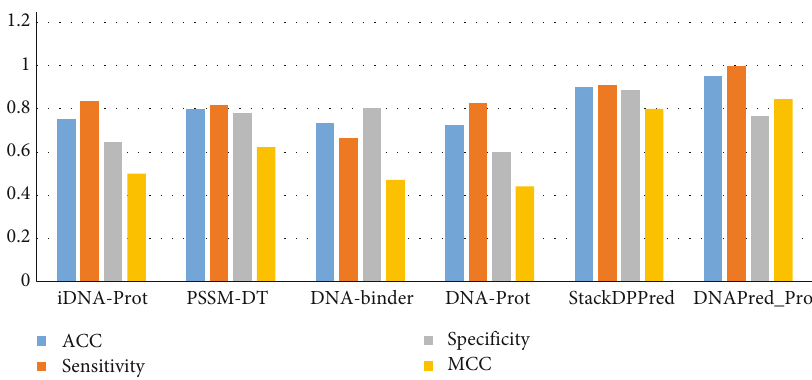
Figure 14: Jackknife results compared with the state-of-the-art predictors.